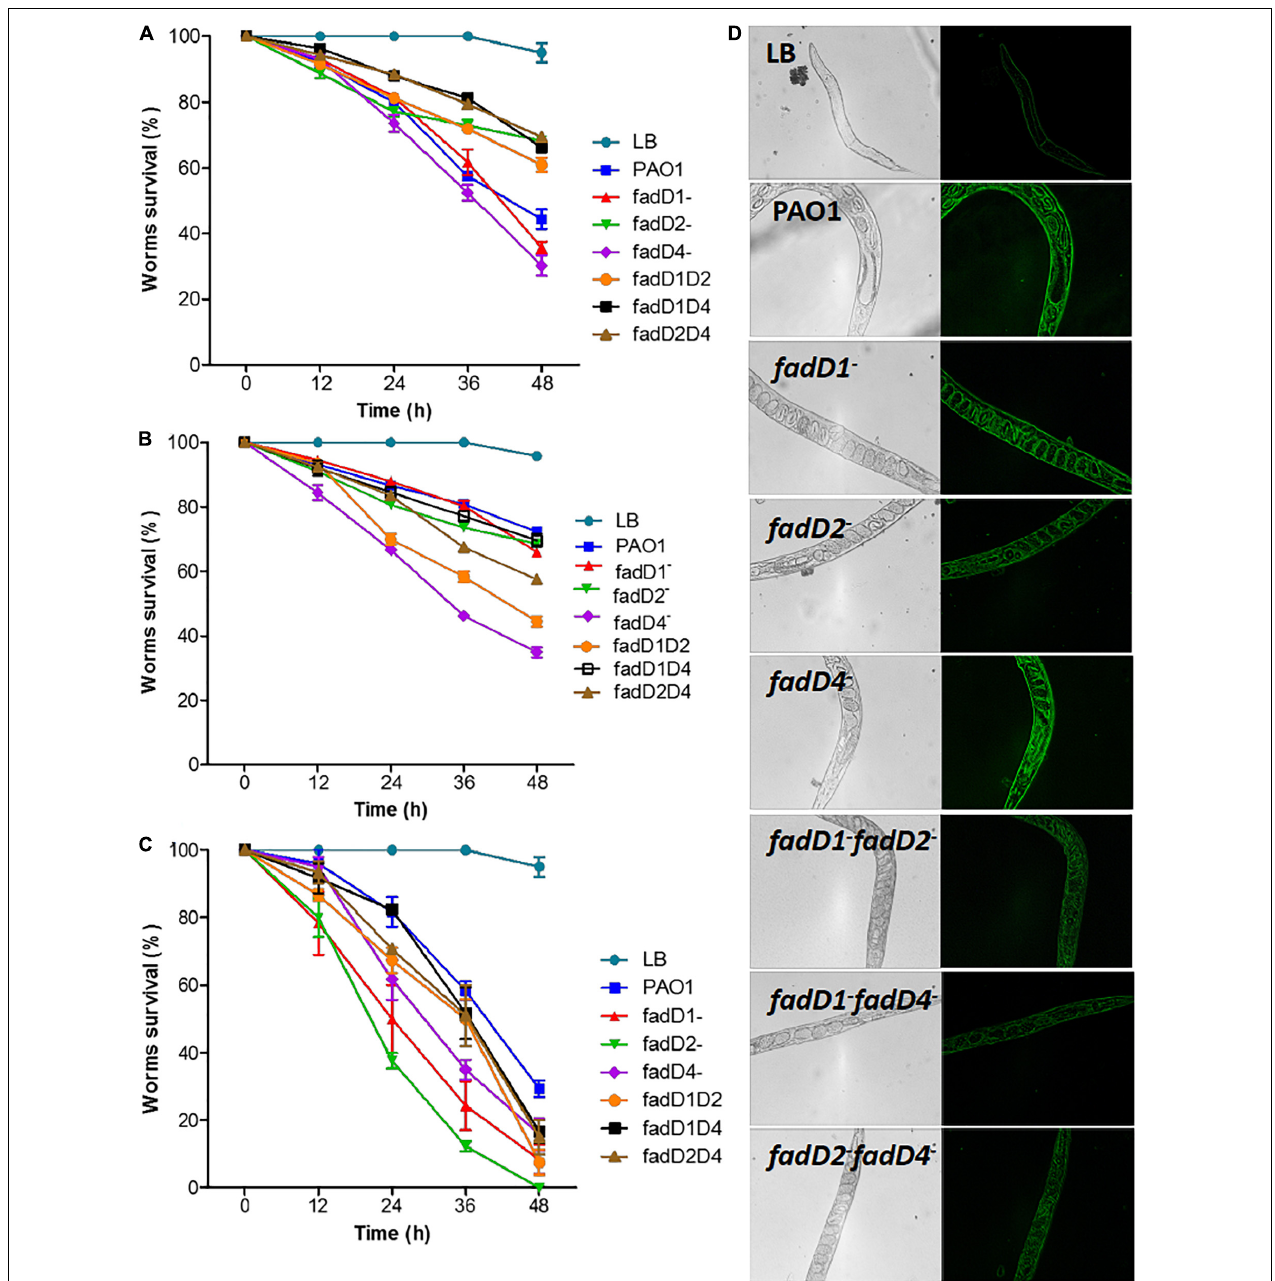
FIGURE 6 | Toxicity of P. aeruginosa PAO1 cultures on C. elegans worms. (A,B) Adult C. elegans worms (20 individuals) were incubated with cell-free supernatants obtained after growth of P. aeruginosa strains for 24 h (A) and 48 h (B) or with complete culture media (C) . Worm survival was determined at indicated times as described in Section “Materials and Methods.” Bars represent mean ± standard error (SE) of three independent assays. (D) Images of oxidative stress responses of CL2166 worms to bacterial